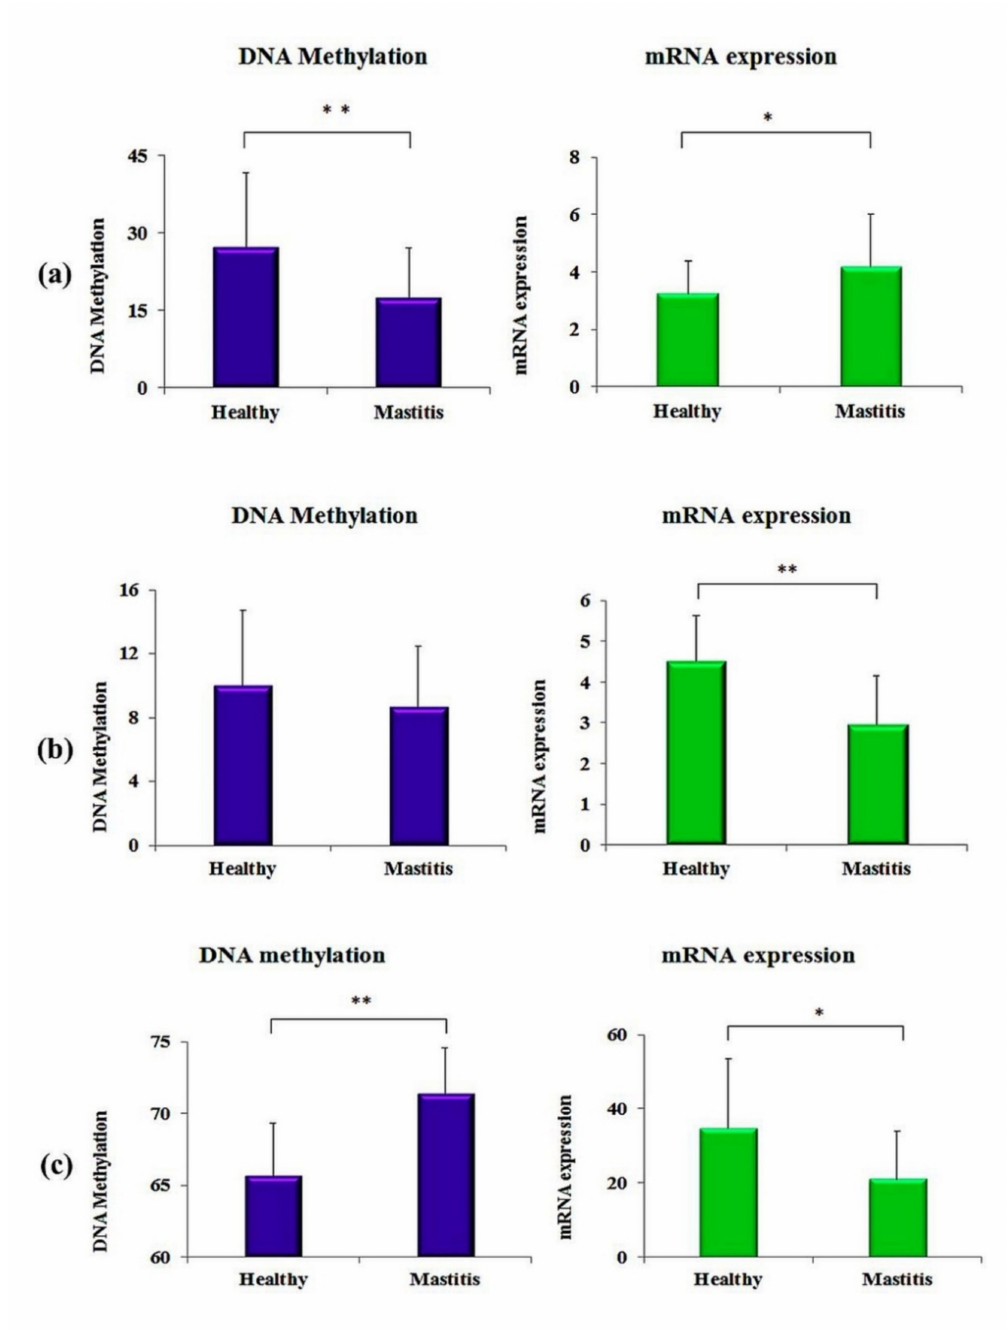
Figure 3. Results of CpG site methylation and mRNA expression in the clinically mastitic cows and in healthy controls: ( a ) JAK2 gene, ( b ) STAT5A gene, ( c ) CD4 gene. The asterisk “*” symbol shows the values are significant at ( p < 0.05) and the “**” shows that values are significant at ( p <